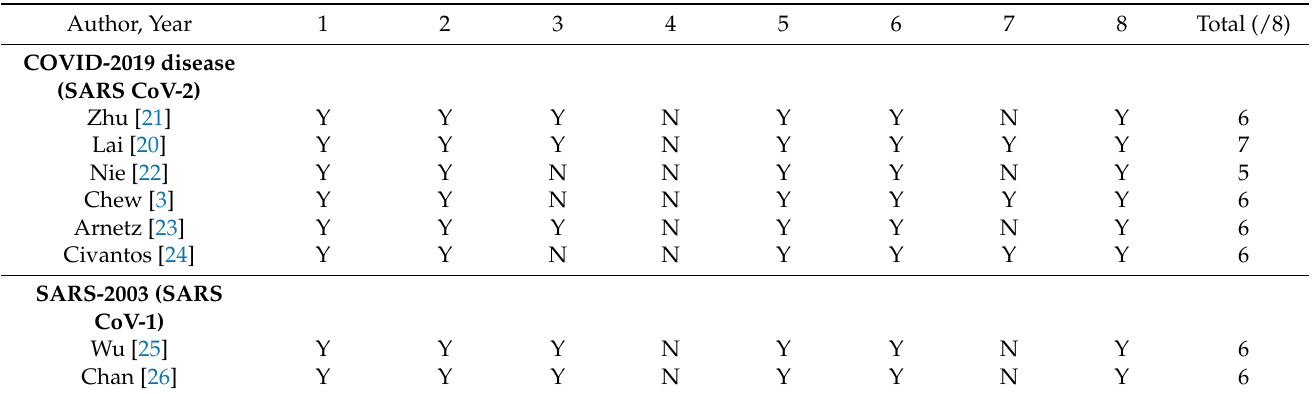
Table 2. Quality assessment of included studies.